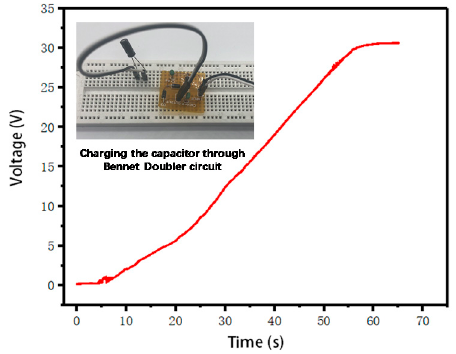
Figure 13. Super capacitor charging curve and Bennet’s doubler circuit (inside).